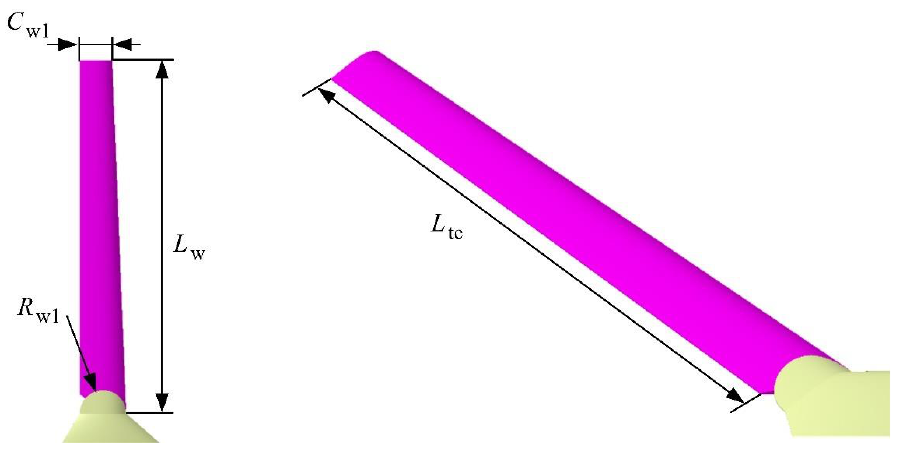
7 of 17 Figure 5. Model of the aircraft with variable swept-back wing. Table 1. Main dimensions of the fuselage.